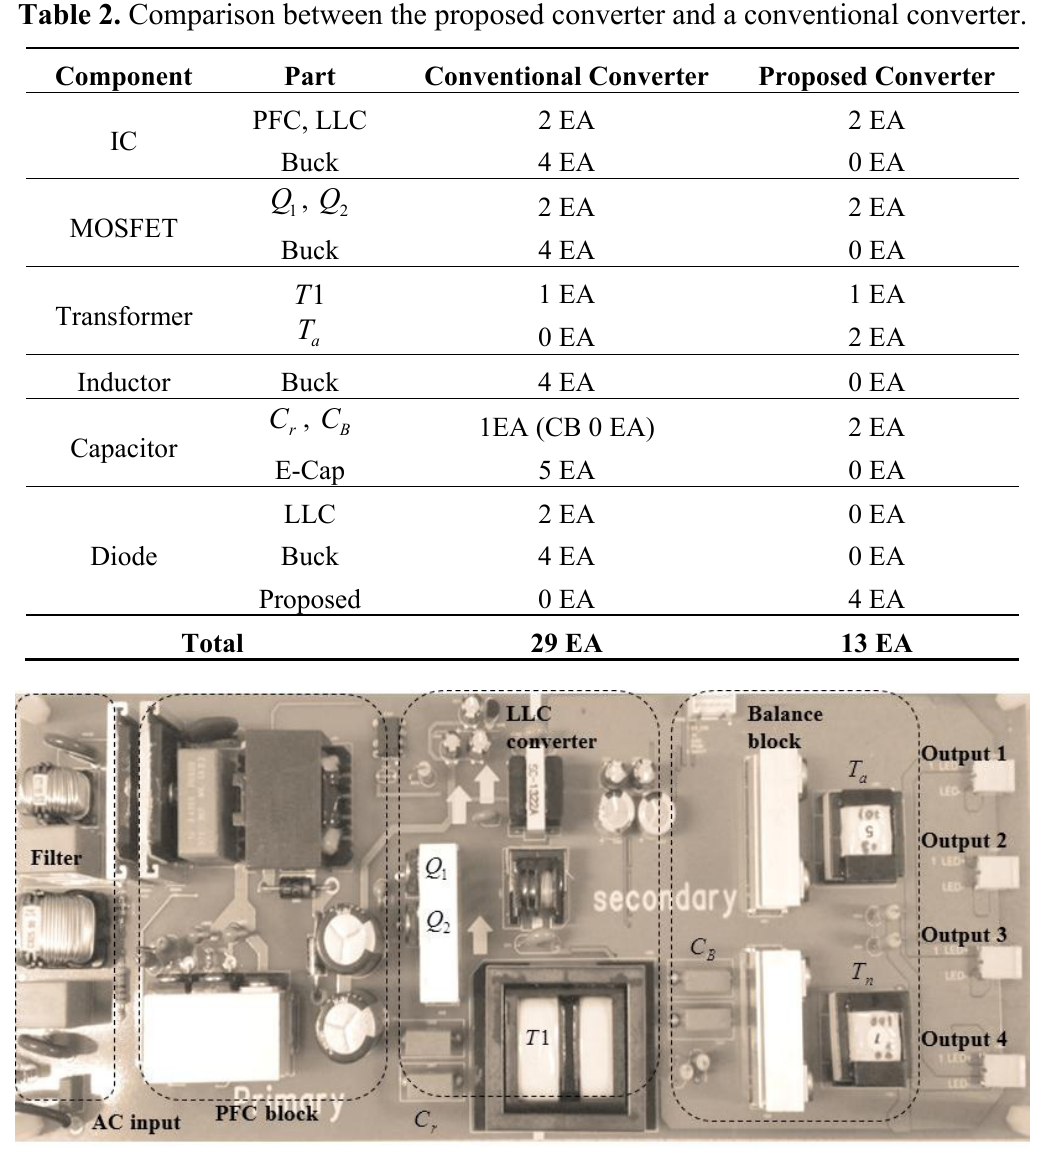
Figure 20. Photograph of the proposed